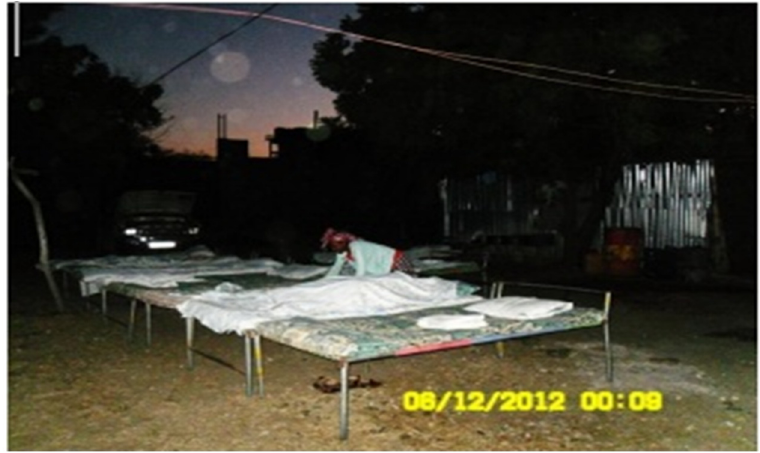
Figure 29. Beds furnished outdoor for sleep